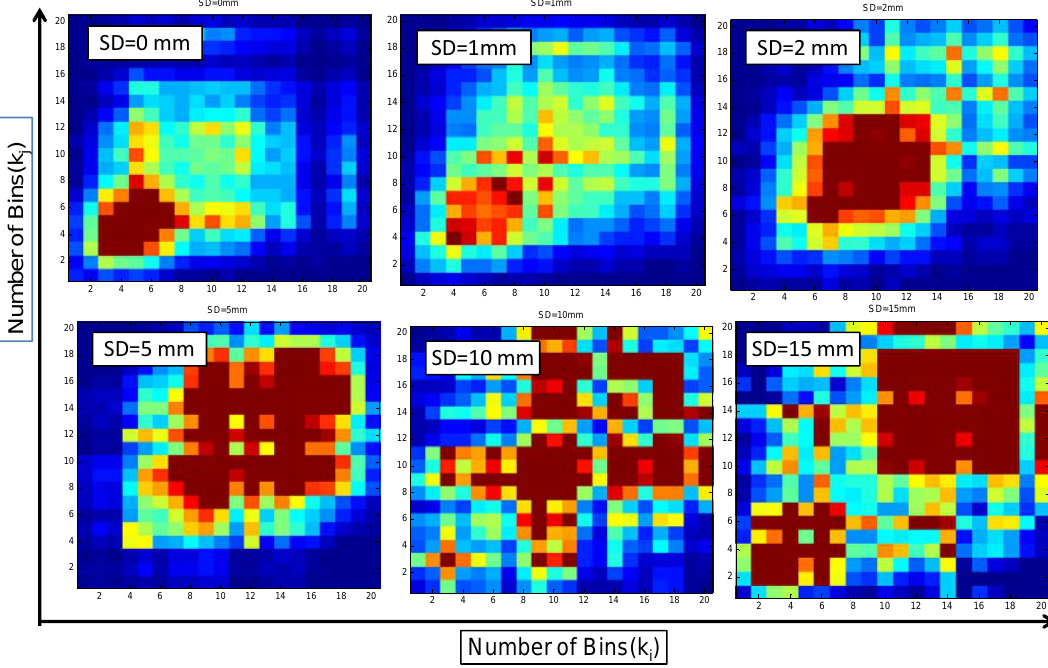
Figure 6. Joint degree distribution evolution for perpendicular aperture-friction networks from SD=0mm to SD=15 mm.